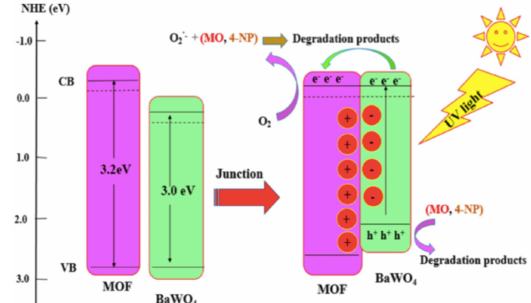
Figure 4. The mechanism for photocatalytic degradation of methyl orange and 4-nitrophenol using composite photocatalyst (MOF-199-NH 2 / BaWO 4 ). Reproduced with permission from Reference [93]. 3. MOFs and Composites for Adsorption and Photocatalytic Degradation of Emerging